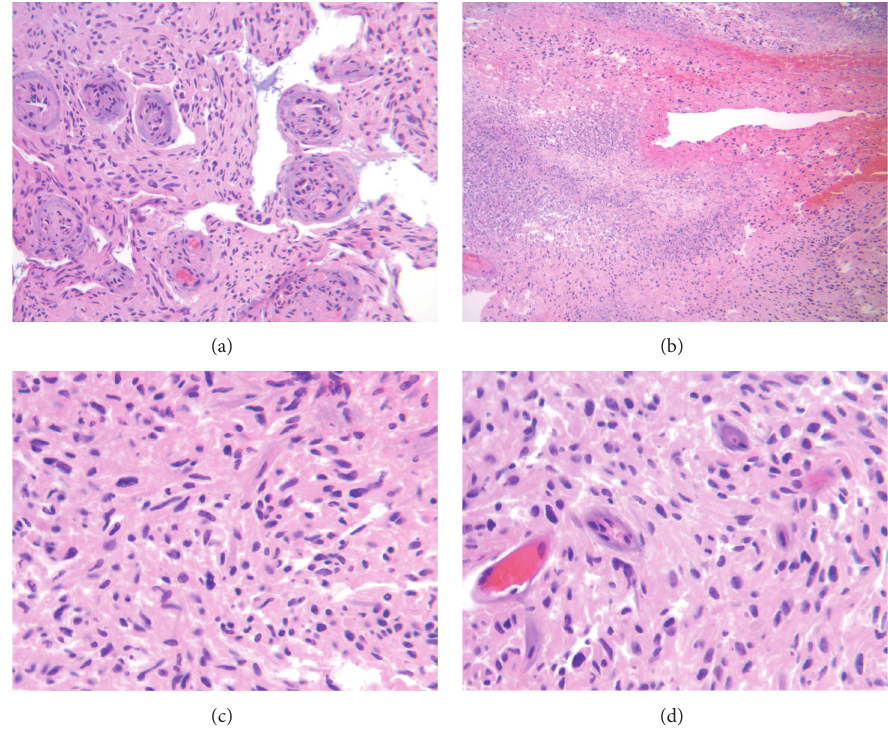
Figure 2: Photomicrographs displaying pathognomonic histopathological features of glioblastoma. (a) Microvascular proliferation with endothelial layer hyperplasia. (b) Areas of geographic necrosis are present. (c) Microscopic examination reveals a hypercellular neoplasm with large, hyperchromatic, pleomorphic cells with cerebellar granular layer cells on the left. (d) Mitotic figures are readily identified in a background of pleomorphic, hyperchromatic neoplastic cells. H&E; original magnification × 10 (a), × 10 (b), × 10 (c), and × 40 (d).